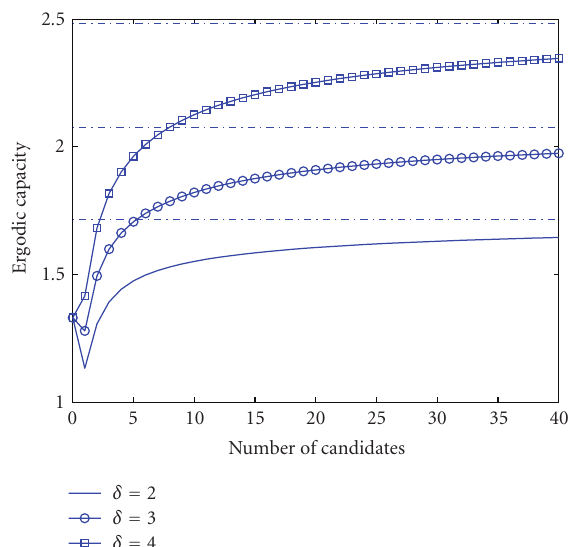
Figure 7: Ergodic capacity of single-relay selection system with up to 40 candidate nodes.